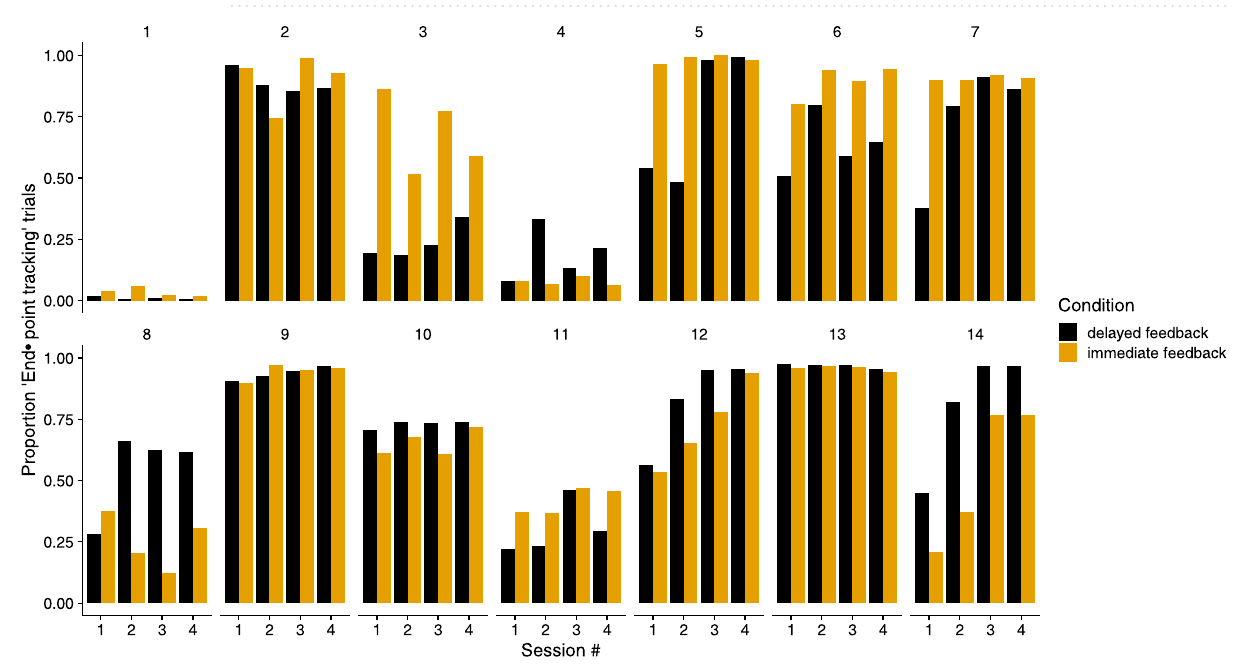
Figure 3. Proportion of trials in which participants adopted the end-point tracking strategy (i.e., the head was oriented towards the shooting location during all the trajectory). This proportion is shown for the two conditions (color coded) and for each participant (different panels) as a function of the session